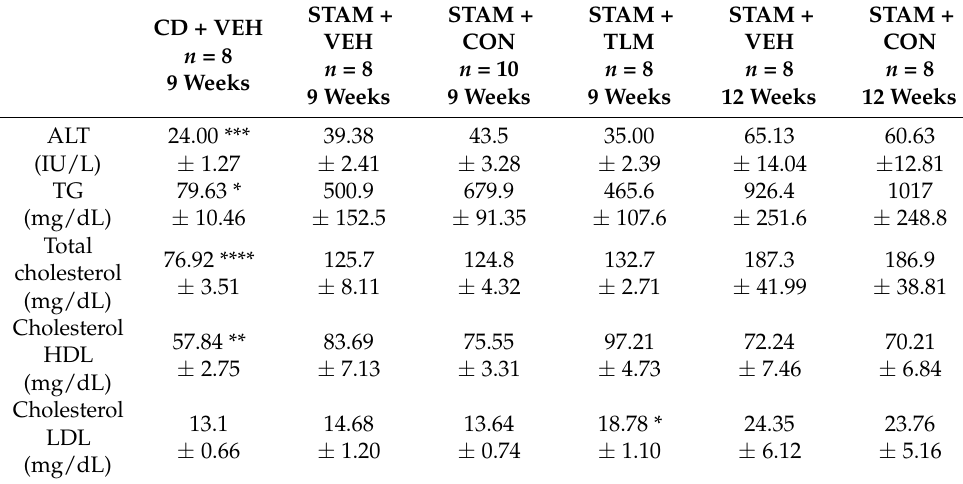
Table 5. Biochemical characteristics after 4 weeks of intervention in the STAM™ mouse